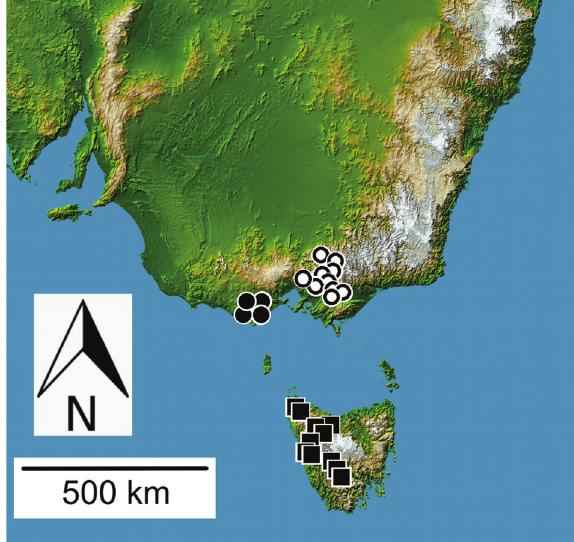
Figure 9. Distributional records for Theprisa spp.: T. otway (black circle); T. convexa (black square); T. montana (white